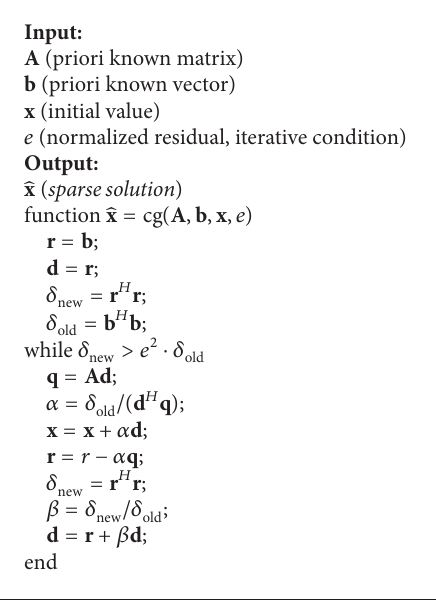
Algorithm 1: Pseudocode of CG